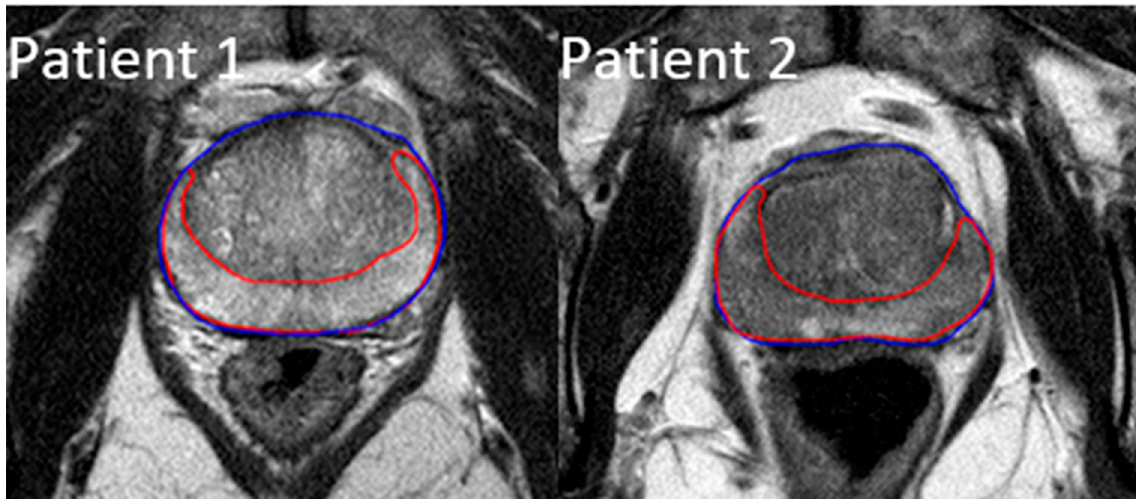
Figure 1. Example contours of the prostate region of interest (ROI) (blue) and the peripheral zone ROI (red).